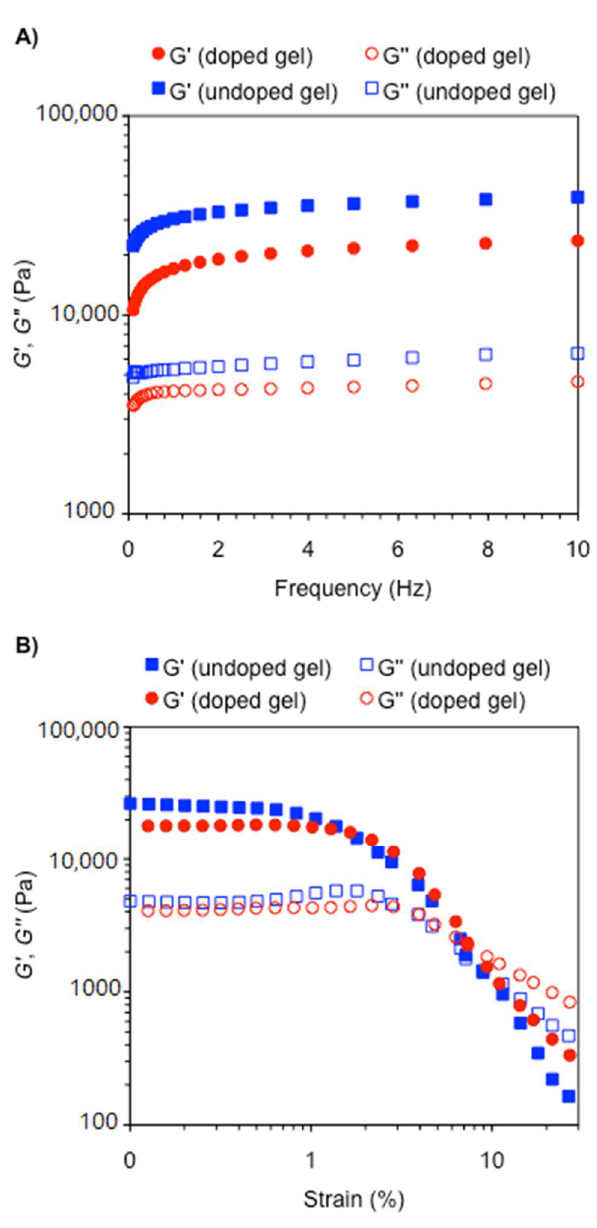
Figure 10. ( A ) DFS and ( B ) DSS measurements of undoped gel made of 1b in CHCl 3 (c = 14 g/L), and doped gel made of 1b (c = 14 g/L) and mandelic acid (molar ratio 1b :acid = 0.1) in CHCl 3 . Finally, the observed disrupting effect of the acids on the supramolecular aggregates of 1b could also be related to changes in the microstructure of the xerogels obtained by freeze-drying the corresponding gels. An entangled microfibrillar network over a dense and continuous structure was observed for updoped xerogels (Figure 11), whereas the incorporation of 10 mol% of mandelic acid (with respect to 1b ) induced the formation of laminar and smoother structures (Figure 11A vs. Figure 11B). The discontinuous appearance of the doped xerogel could explain a less-effective immobilization of solvent molecules, which is in agreement with the observed lower T gel and mechanical strength of the bulk material. In contrast, FE-SEM images of the corresponding xerogels showed little effect on the microstructure in comparison with the undoped network (Figure 11C vs. Figure 11D). It is worth mentioning that the harmful effect of acids on the stability of supramolecular gel networks was not exclusive to urea 1b